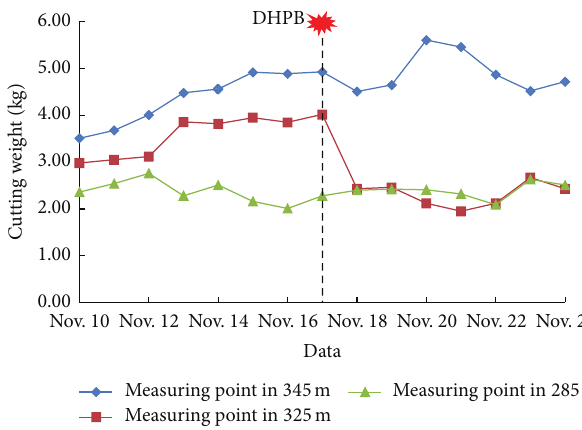
Figure 5: Cutting weight variation before and after blasting.